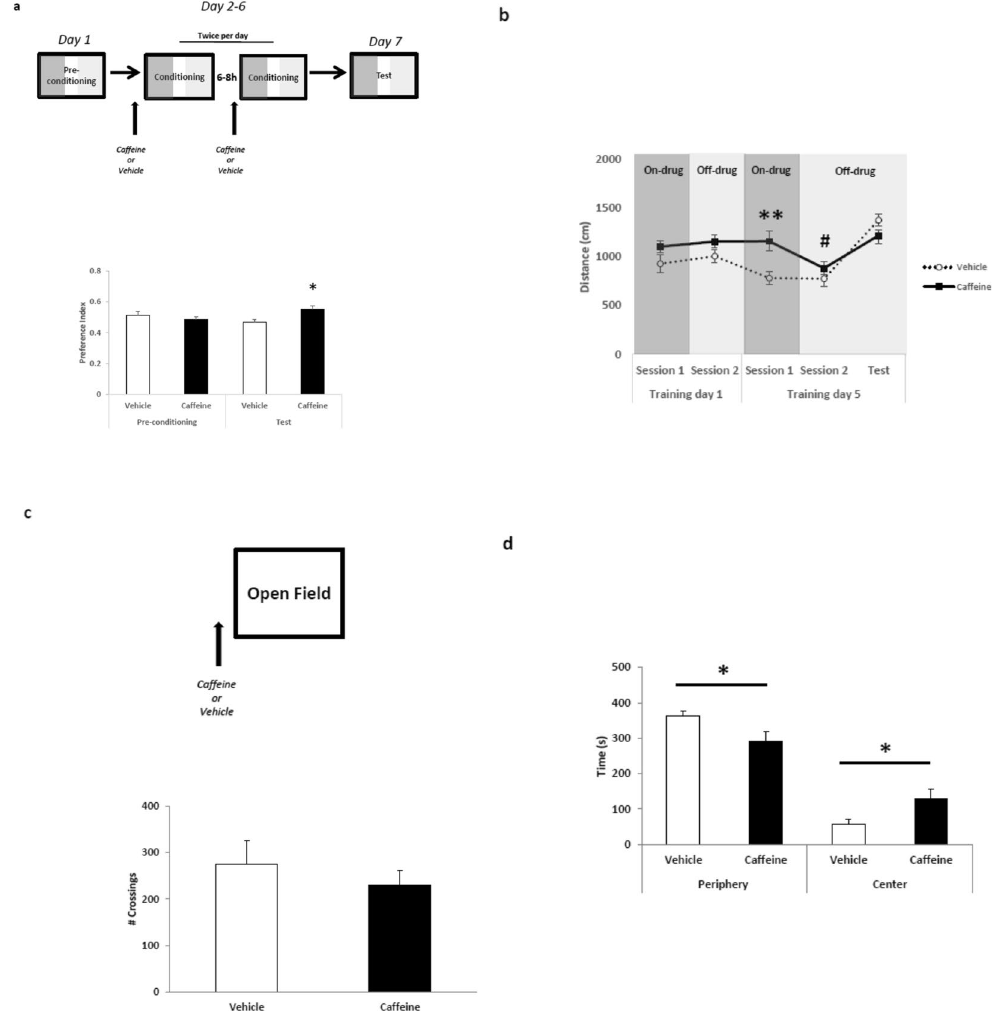
Figure 3. Caffeine induces conditioned place preference and anxiolytic-like behavior in the open field. The graphs show preference index during CPP (caffeine-paired chamber/caffeine-paired chamber + vehicle-paired chamber), number of crossings and time spent in the periphery and center of the open field, respectively. Experimental design is shown at the top of each panel; ( a ) Animals express preference for caffeine-paired chamber compared to control during CPP test session (Vehicle n = 10 and Caffeine n = 8); ( b ) Caffeine-treated animals express higher locomotion during the conditioning day 5 compared to control group and within sessions in an off-drug condition. However, no differences were found on day 1 and in the test session– (Vehicle n = 10 and Caffeine n = 8); ( c ) No difference was detected in number of crossings; ( d ) Caffeine-treated animals spent less time in the periphery and more in the center of the open field, suggesting an anxiolytic effect of acute caffeine administration (Vehicle n = 7 and Caffeine n = 7). * p < 0.05, ** p < 0.01 differences between groups (vehicle vs. caffeine) and within sessions (on drug vs. off drug), # p < 0.05, differences between conditioning sessions (day 1 vs. day